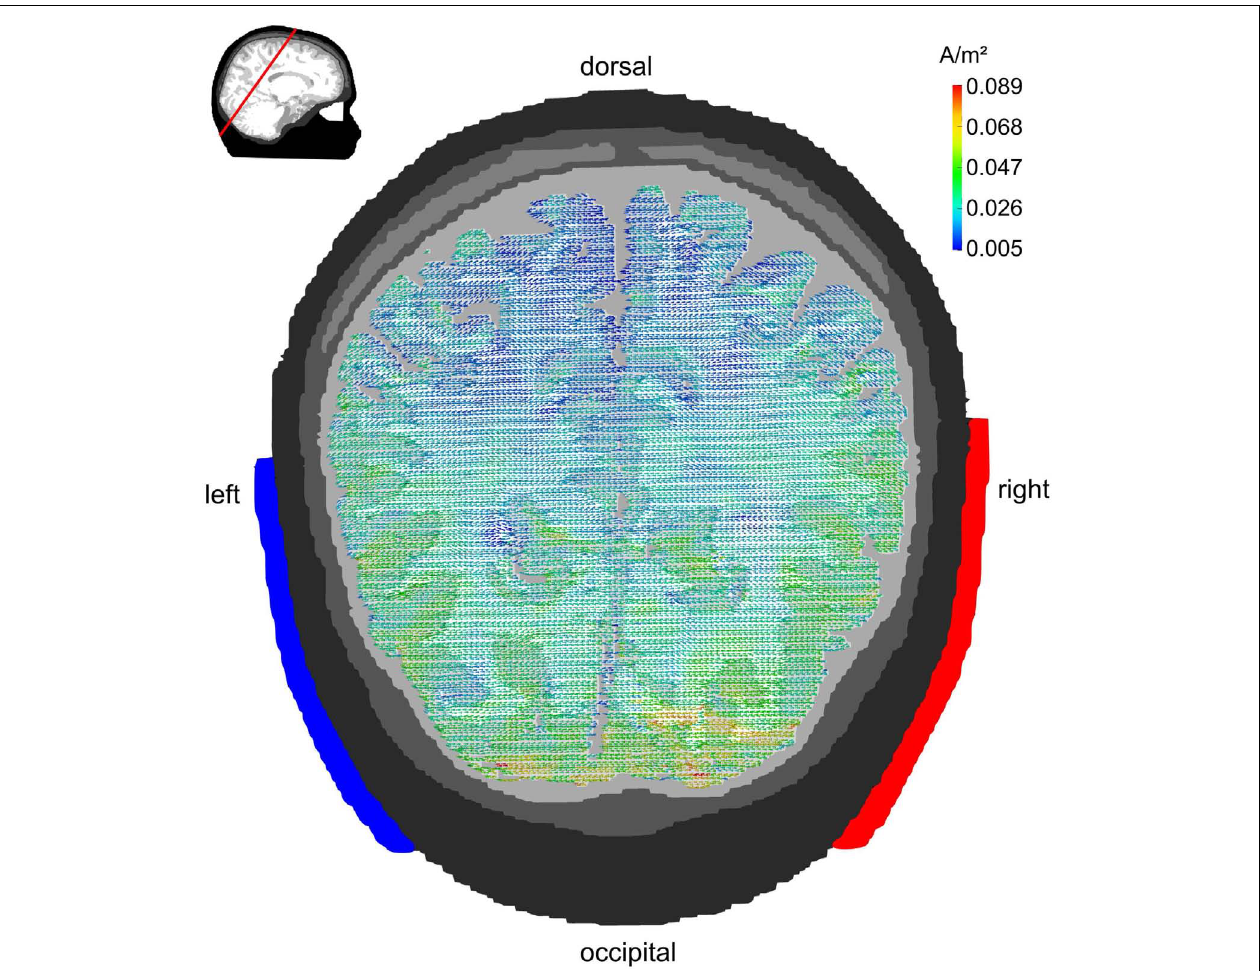
However, the current flow is not restricted to occipital cortex but reaches also parietal and temporal cortex.The embedded figure in the upper left corner depicts the section